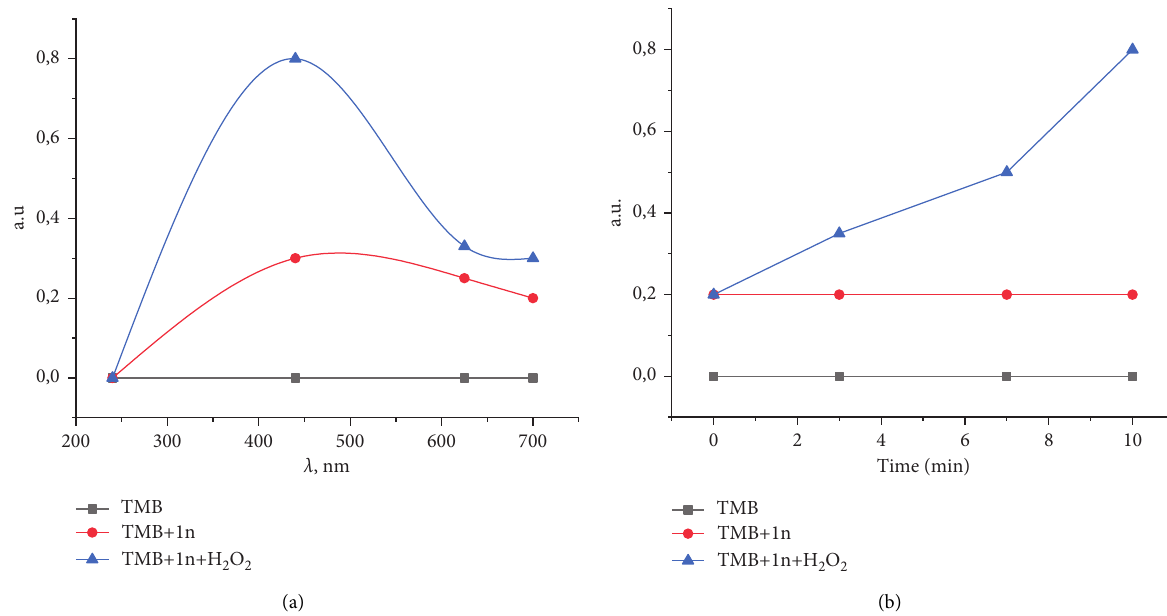
Figure 6: (a) Absorbance spectra from 200 to 700nm of TMB (grey line), TMB + 1n (red line), and TMB+ 1n +H dependent absorbance changes at 440nm of oxidized TMB (grey line), TMB + 1n (red line), and TMB + 1n +H 2 O 2 (blue